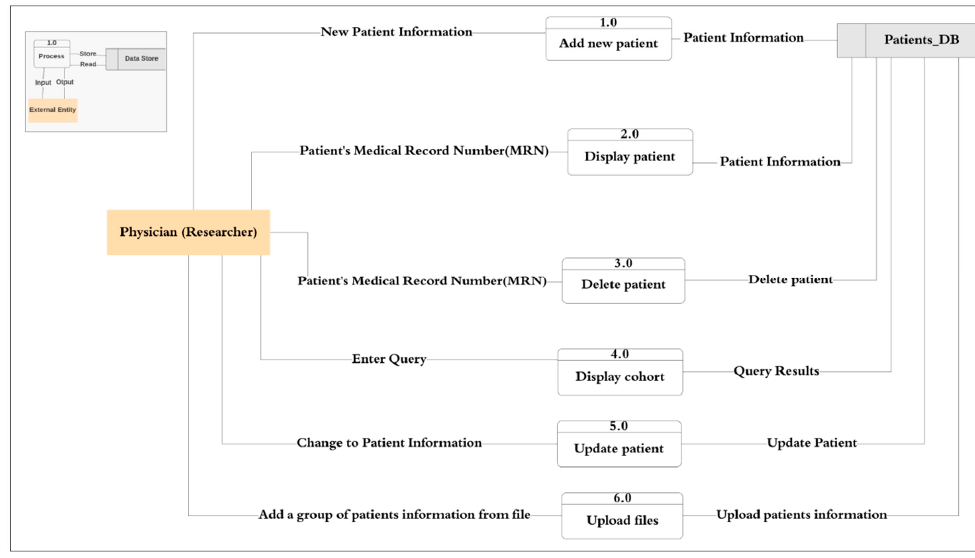
Figure 6. The logical process flows for DFD level 1.